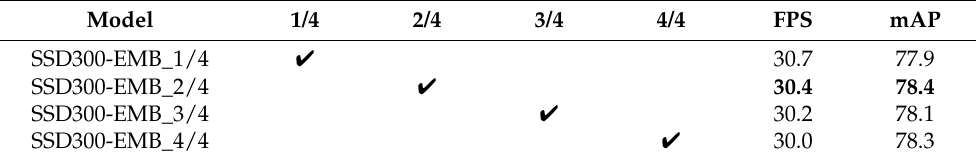
Table 6. Influences of feature map split on the PASCAL VOC 2007 test set. Bold indicates our model adopted by the ablation